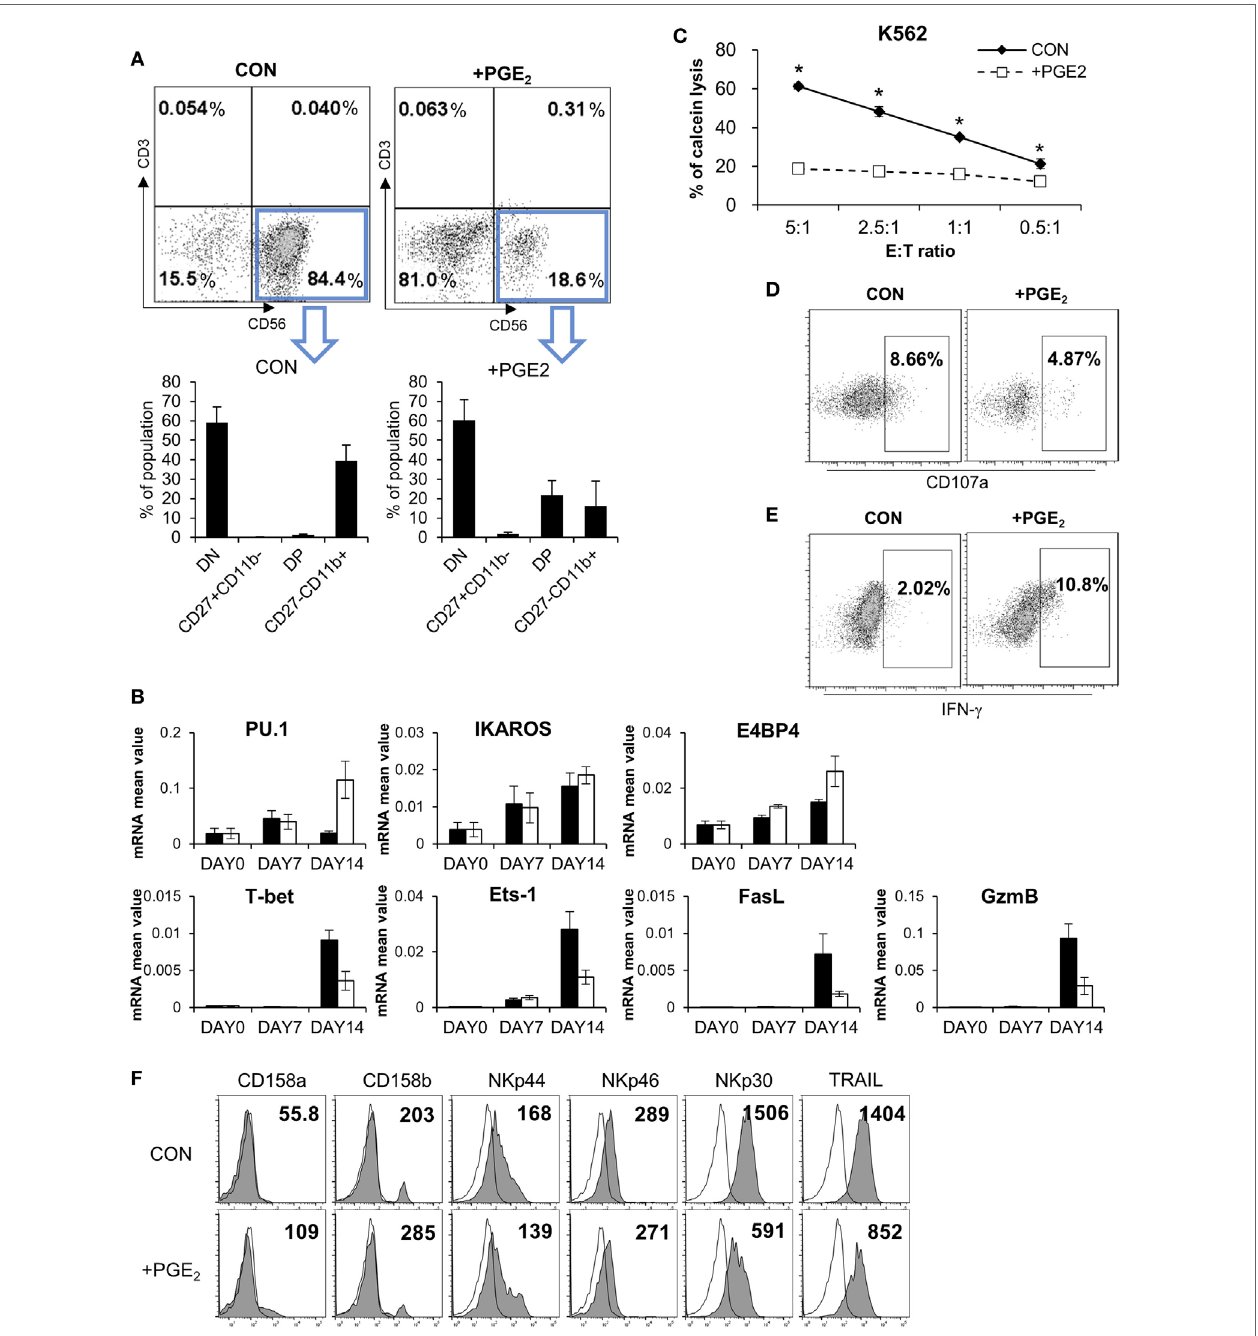
FigUre 6 | PGE2 inhibits functional maturation of natural killer (NK) cells. (a) Flow cytometry analysis of CD27 and CD11b expression in gated CD56 + NK cells differentiated from CD34 + Hematopoietic Stem Cells. CD56 + NK cells were divided into four subsets based on the differential expression of CD27 and CD11b; double negative, CD27 + CD11b − , double positive, and CD27 − CD11b + . (B) mRNA levels detected by real-time PCR. Glyceraldehyde 3-phosphate dehydrogenase primer was used as an internal control. (c) pNK cells were cultured in complete mNK differentiation medium in the absence (CON: black diamond) or presence of 100 ng/ml of PGE (PGE2: white square) for 14 days; CD56 + NK cells were sorted by flow cytometry. Cytotoxicity of NK cells was assessed against K562 cells using calcein-AM. Bars represent mean ± SD of three independent experiments. Statistical analysis was performed using the paired two-tailed Student’s t -test (* P < 0.05). (D) Expression of CD107a (degranulation marker of NK cells indicating cytolytic ability) was evaluated by flow cytometry. Numbers in the box represent percentage of CD107a + expression. (e) IFN- γ expression in NK cells detected by flow cytometry. Numbers indicate percentage of positive expression. (F) Analysis of CD158a, CD158b, NKp44, NKp46, NKp30, and TRAIL (filled profiles) expression by flow cytometry. White profiles represent isotype controls. Numbers indicate mean fluorescence intensity. Y -axis shows cell counts.